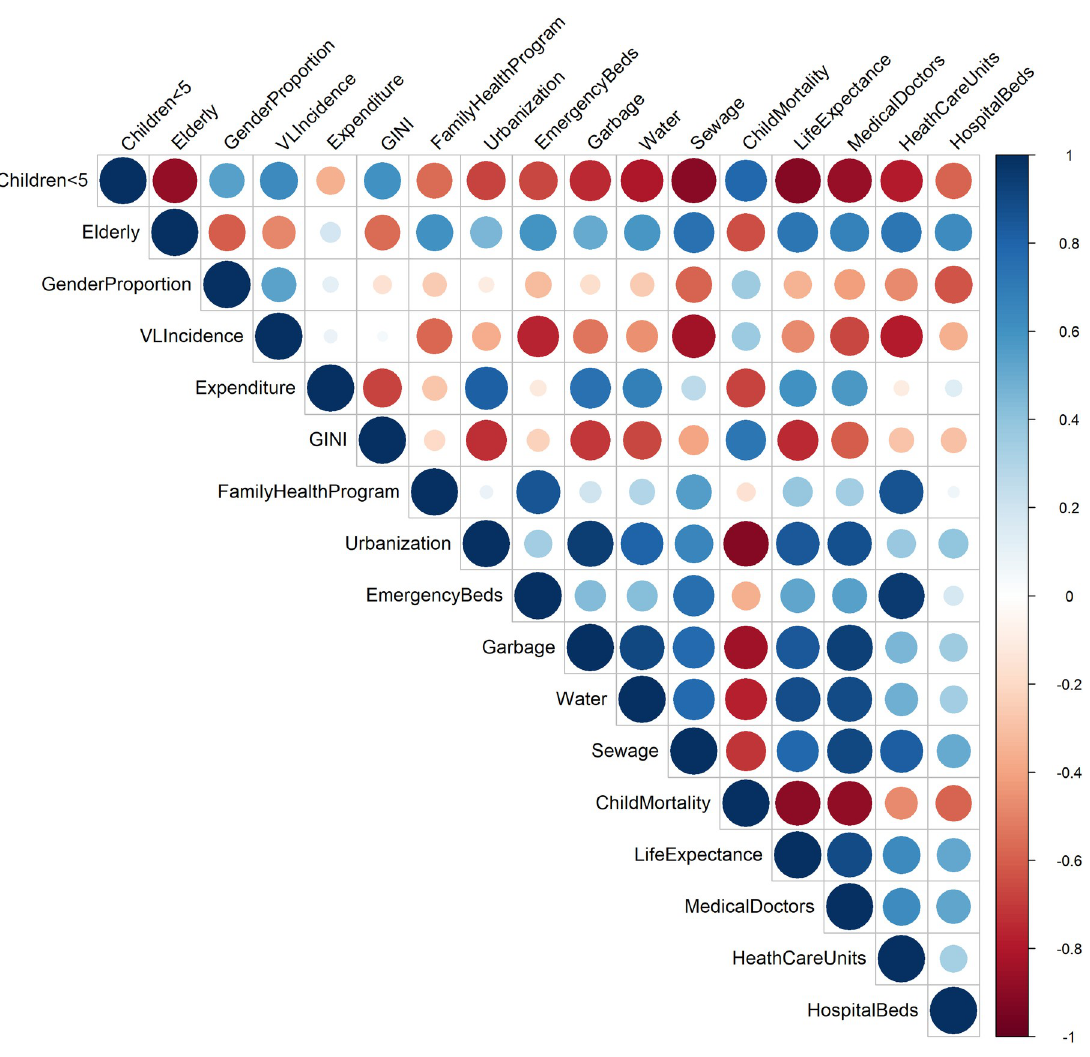
Fig 4. Correlation matrix for contextual